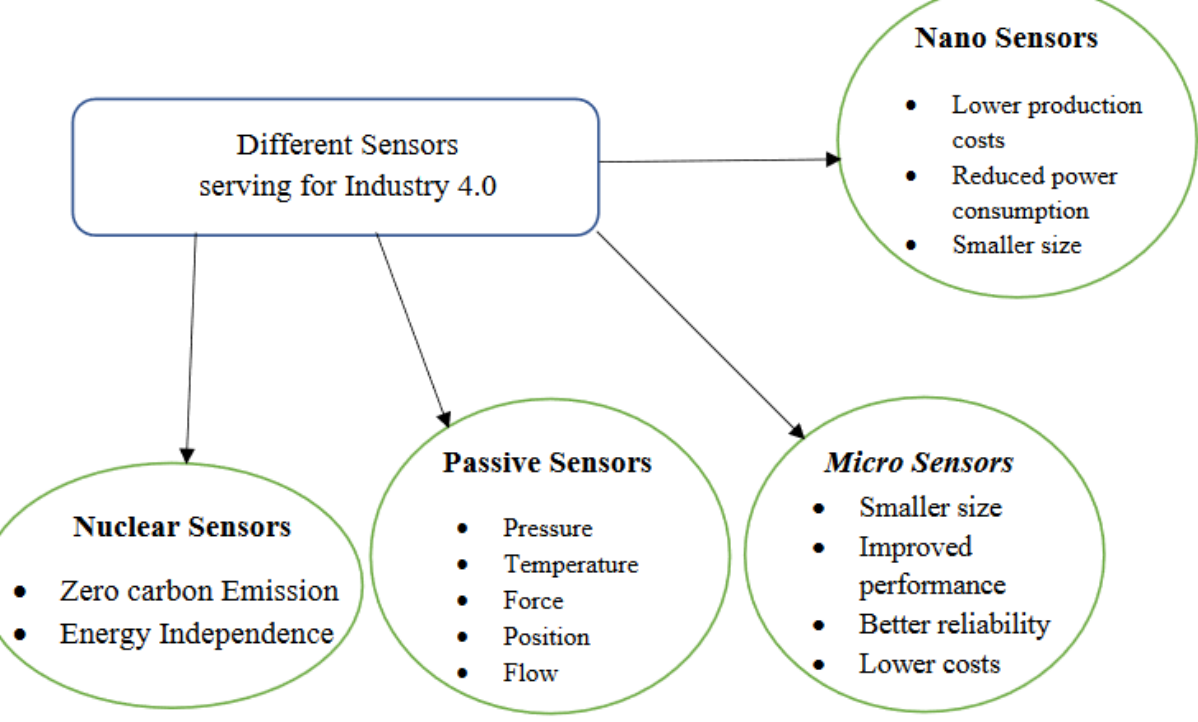
Figure 15. Sensors with various capabilities for Industry 4.0.